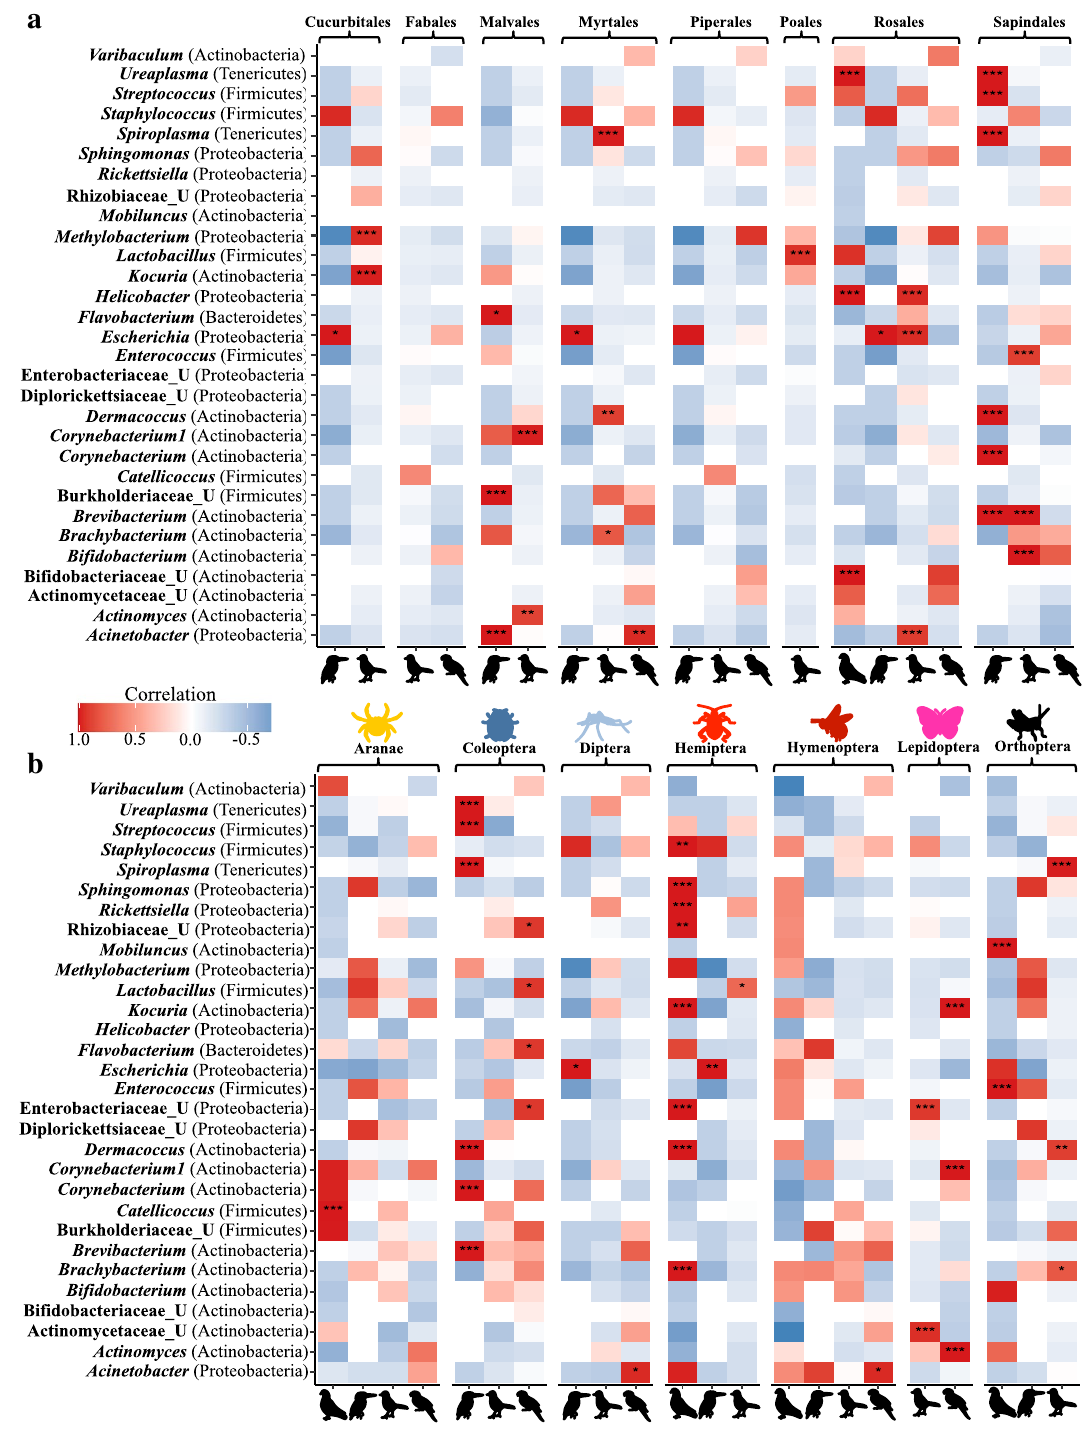
Figure 4. Many host-taxon-specific bacterial genera are significantly positively correlated with the relative abundance of certain dietary components. Pearson’s correlations between the 30 most abundant cloacal bacterial genera and the proportion of different orders of plants ( a ) and invertebrates ( b ) in individual diets. These analyses were conducted only on the diet identification based on metabarcoding, as visual identification did not identify plants into lower-level taxonomic classifications. Significant correlations are indicated with asterisks ( p < 0.05*, p < 0.001**, and p <